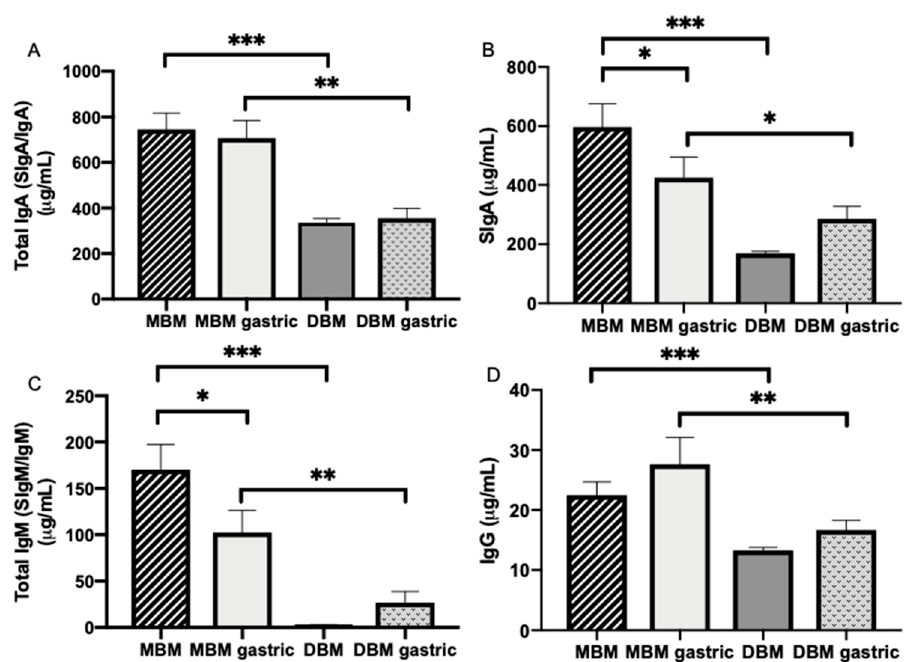
Figure 2. Immunoglobulin concentrations in milk and gastric contents at 1-hour postprandial time from 20 preterm infants (26–36 weeks of gestational age (GA)) fed mother’s own breast milk (MBM) and donor breast milk (DBM). Concentration of ( A ) total IgA (SIgA/IgA), ( B ) secretory IgA (SIgA), ( C ) total IgM (SIgM/IgM) and ( D ) IgG in milk and gastric samples. Values are mean ± SEM, n = 36 for MBM and DBM ( n = 20 for 8–9 days and n = 16 for 21–22 days of postnatal age). Asterisks show statistically significant differences between variables (*** p < 0.001; ** p < 0.01; * p < 0.05) using the Wilcoxon matched-pairs signed-rank test.